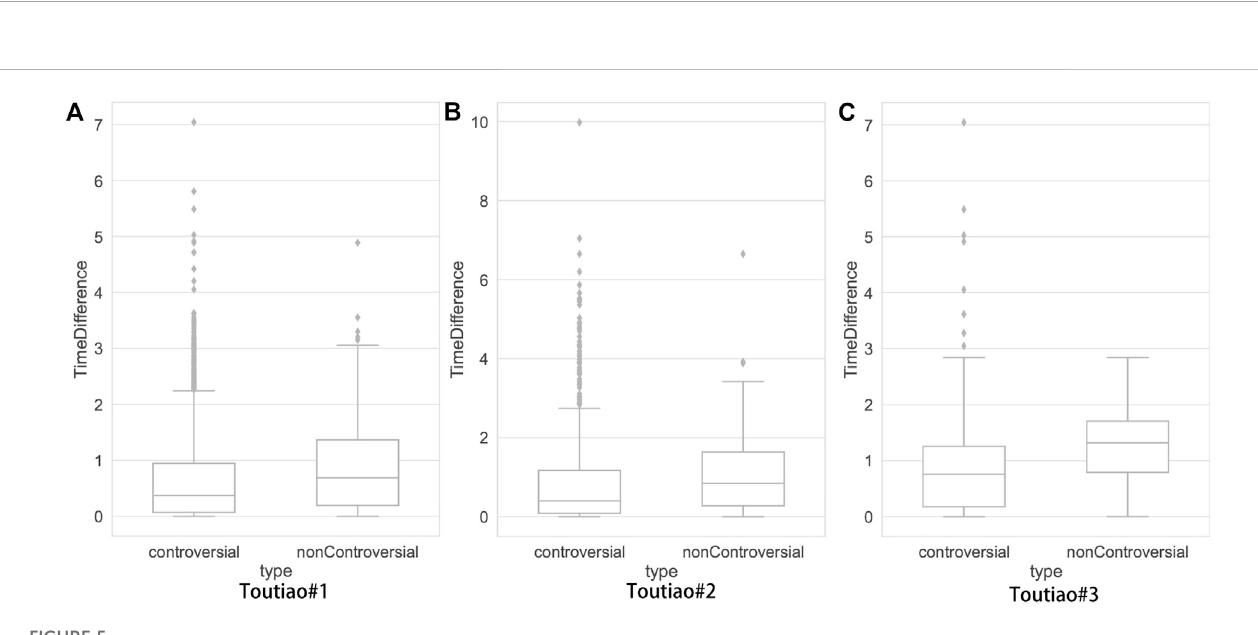
FIGURE 5 Distribution of reply time of comments and their replies. (A – C) represent the results of these three subsets: Toutiao#1, Toutiao#2 and